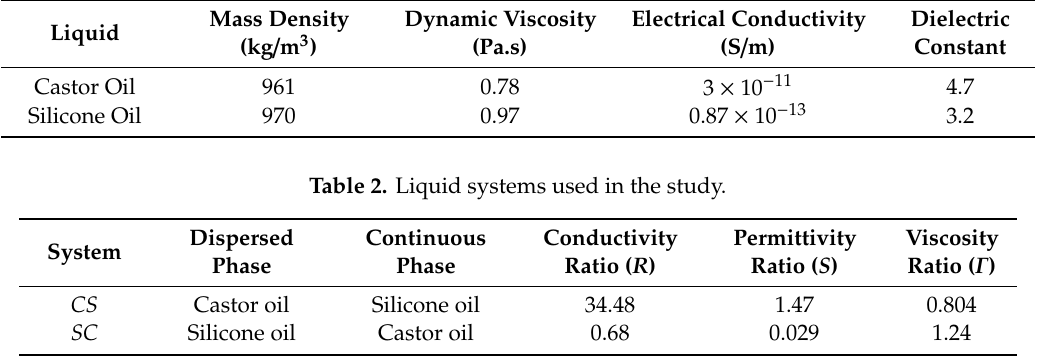
Table 1. Physical properties of the tested base liquids [5].